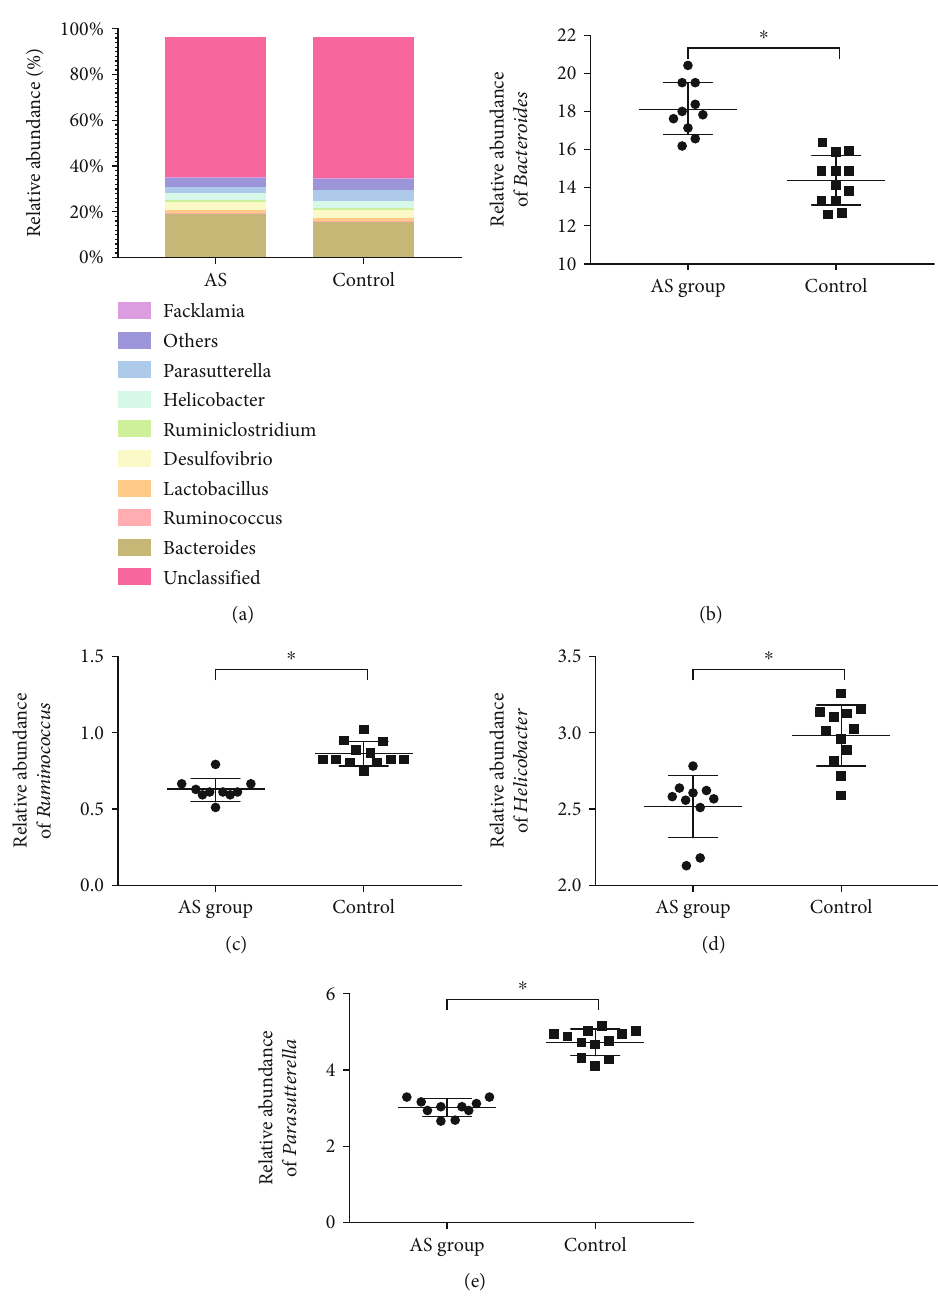
Figure 4: Genus-level examination of microbiota composition. (a) The relative abundance of fecal microbes at the genus level. Intergroup comparison of relative abundance of (b) Bacteroides, (c) Ruminococcus, (d) Helicobacter, and (e) Parasutterella. ∗ P < 0 : 05